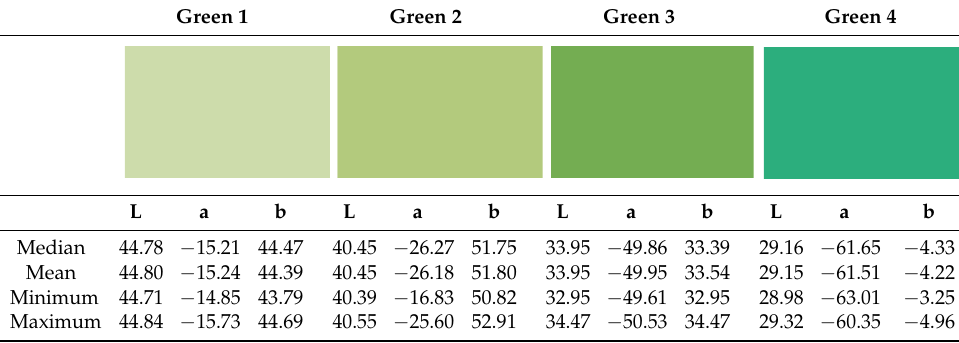
Table 3. Description of the reflection properties of different selected greens. Green 1